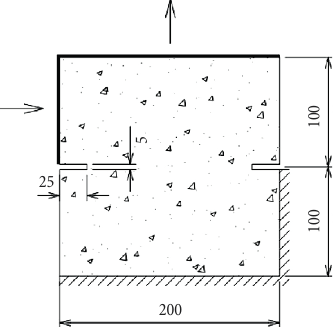
Fig. 11. A dual-border cut specimen (Zi et al. 2007)